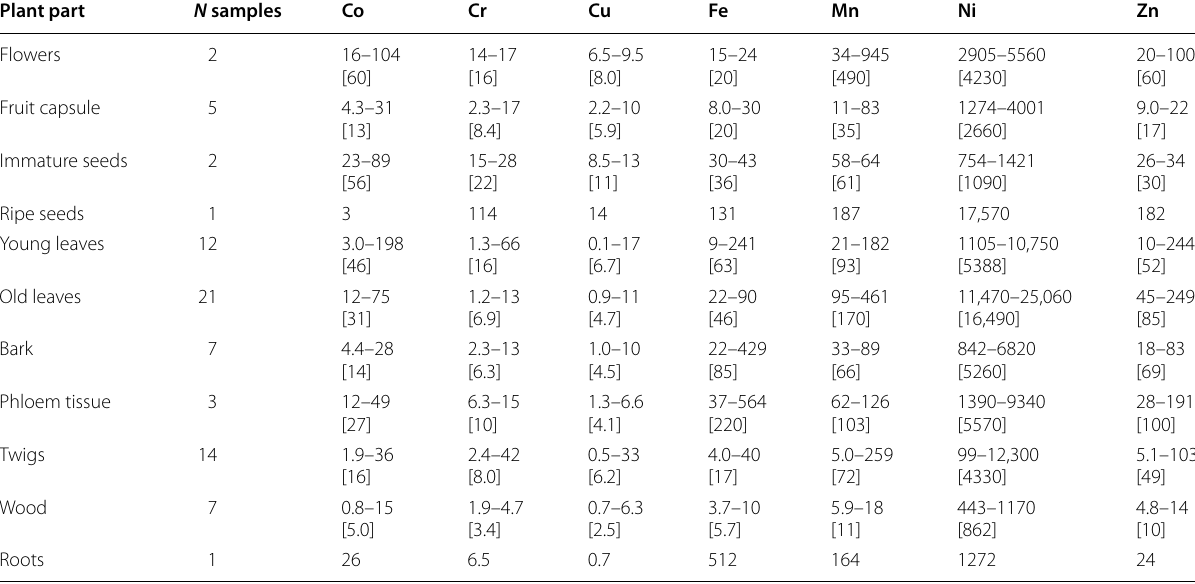
All values provided in μg g −